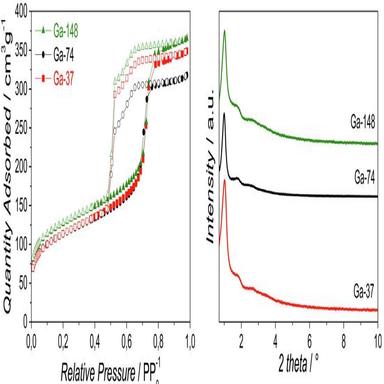
Nitrogen adsorption/desorption isotherms of Ga-silicate solids (left) and small-angle XRD patterns (right).